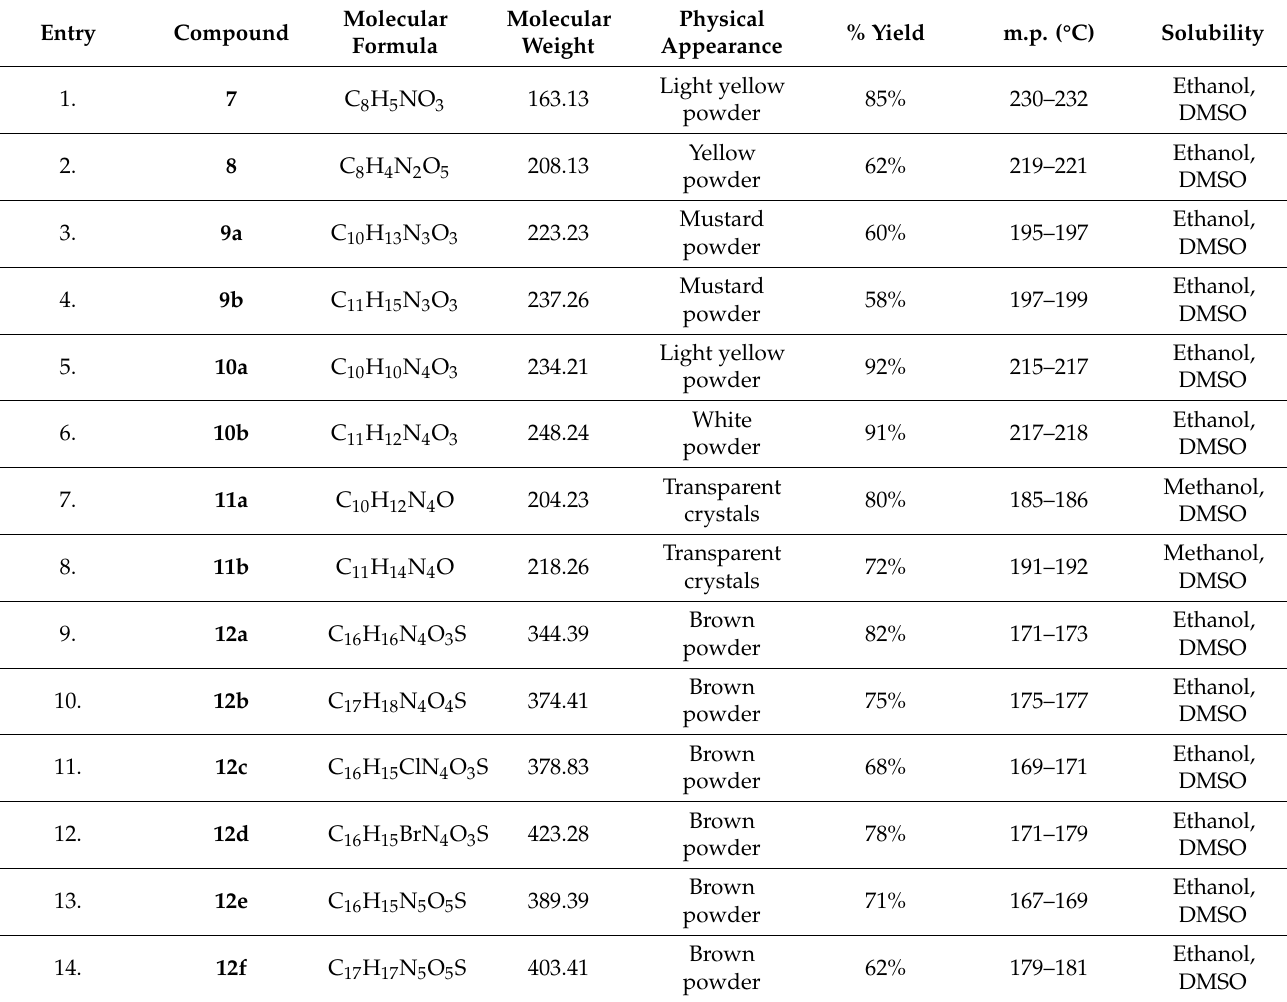
Table 3. Physiochemical properties of all synthesized compounds 7–12f